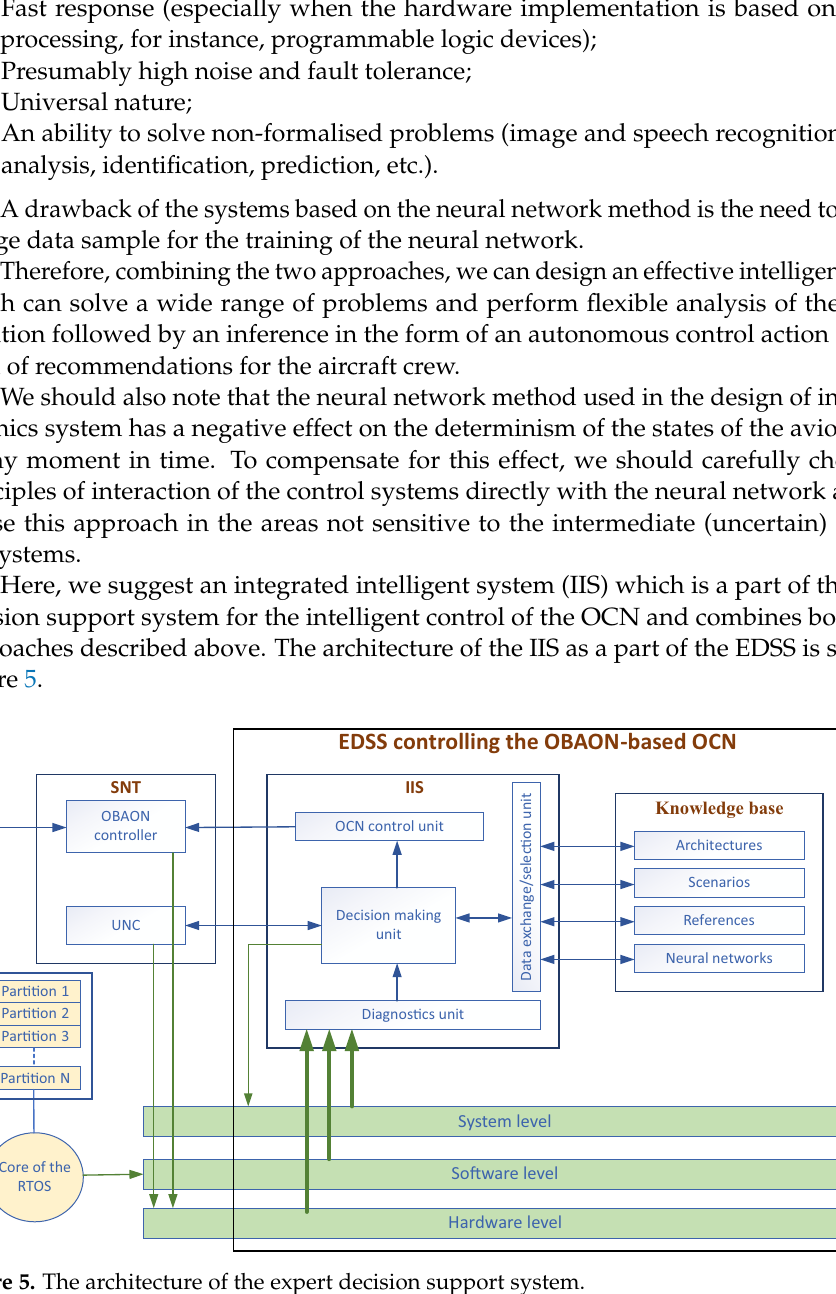
Figure 5. The architecture of the expert decision support